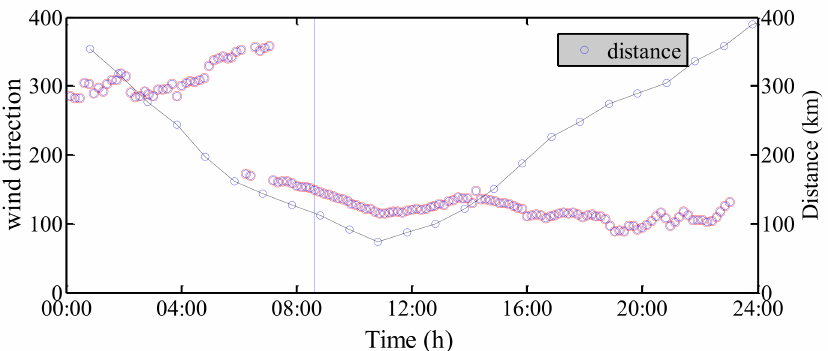
Figure 7. The mean wind direction during Typhoon “Maria”.